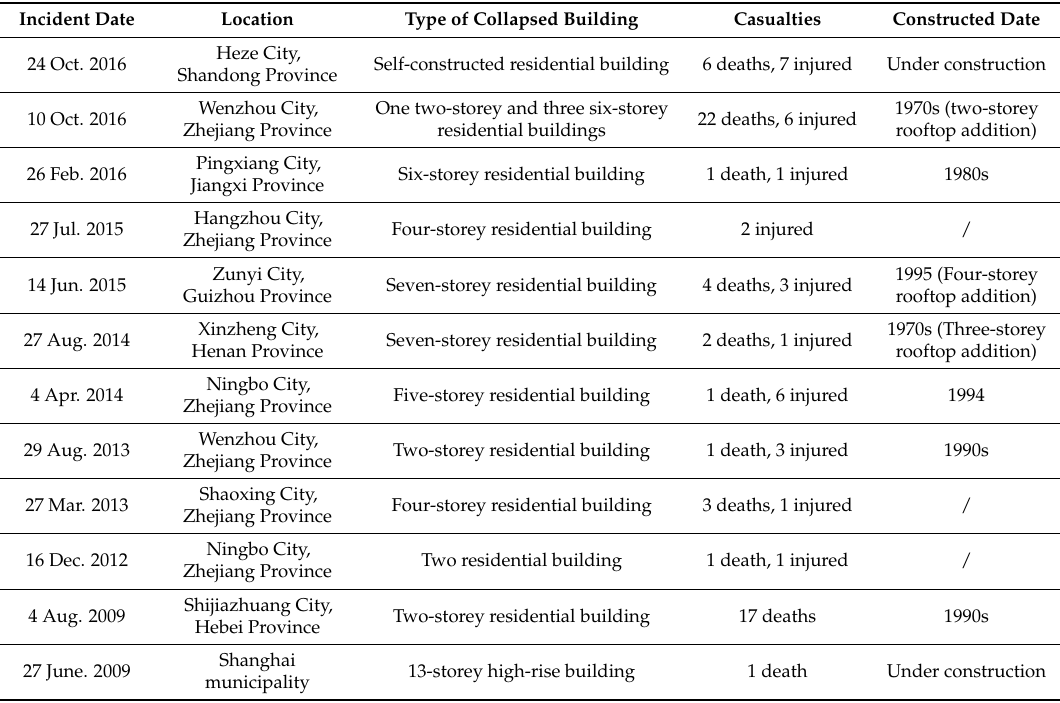
Table 1. Incidents of residential collapse building from 2009 to